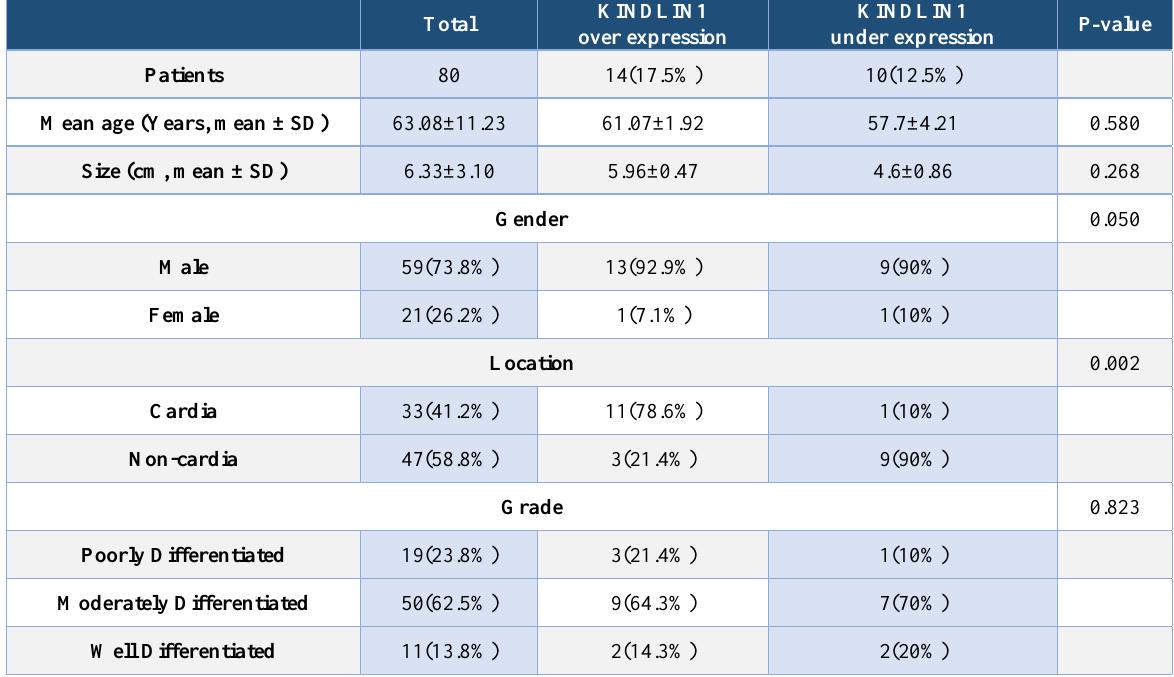
Table 2. Correlation between the level of KINDLIN1 mRNA expression and clinicopathological features of GC